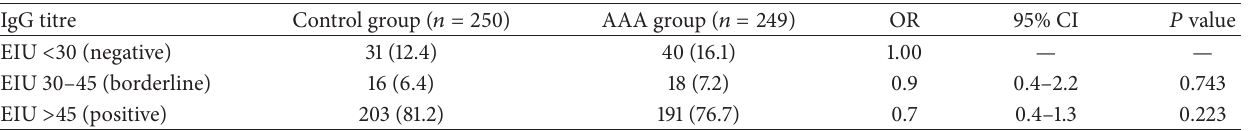
Table 4: Comparison of control and AAA groups based on IgG antichlamydial antibody titres. 𝜒 2 = 1.62 , df = 2, and 𝑃 = 0.444 . The numbers in parenthesis represent percentage.